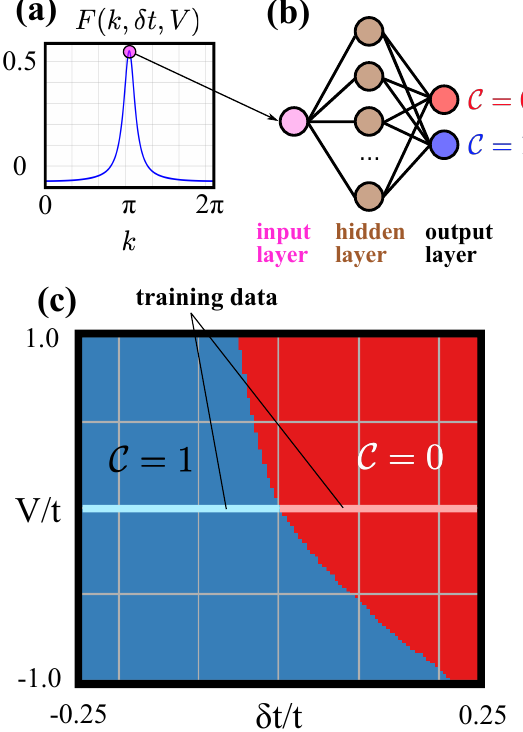
Figure 1: Machine learning scheme to classify different topological phases in the in- teracting SSH model. (a) The profile of the curvature function F ( k , δ t , V ) and the = π used as input data to train a neural network – whose architec- value at the HSP k 0 ture is shown in (b) – to recognize different topological phases. (c) The topological phase diagram predicted by the network for the interacting model ( V (cid:54) = 0), using a one-loop self-energy approximation. The training set is that of the noninteracting SSH model at V = 0 given by the topologically trivial phase δ t > 0 (light red line) and the nontrivial phase δ t < 0 (light blue